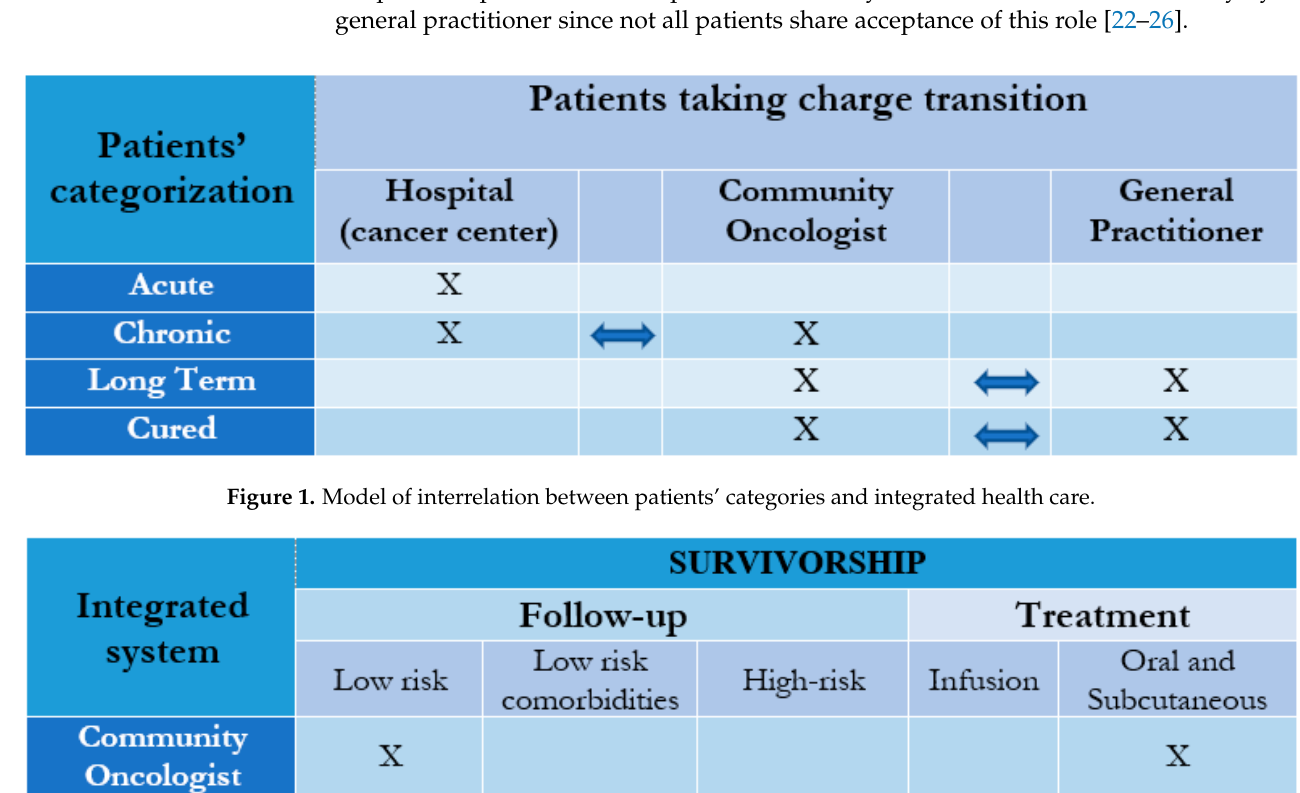
Table 2. Role of the coordinator.